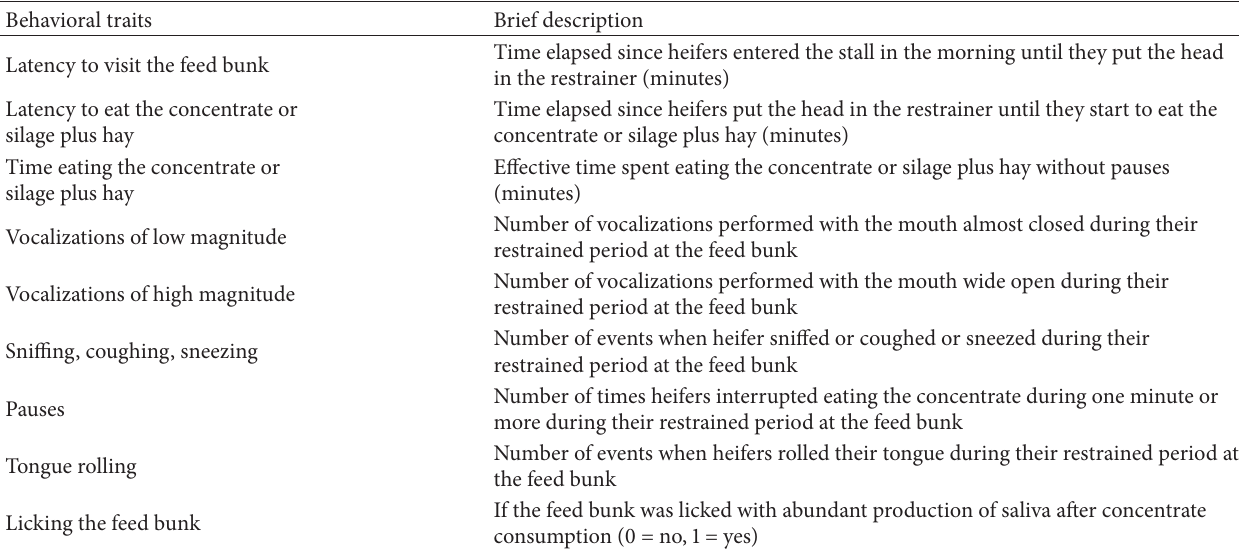
Table 2: Ethogram with the description of behavioral activities performed by dairy heifers when fed with Oregano extract at the feed bunk. Behavioral